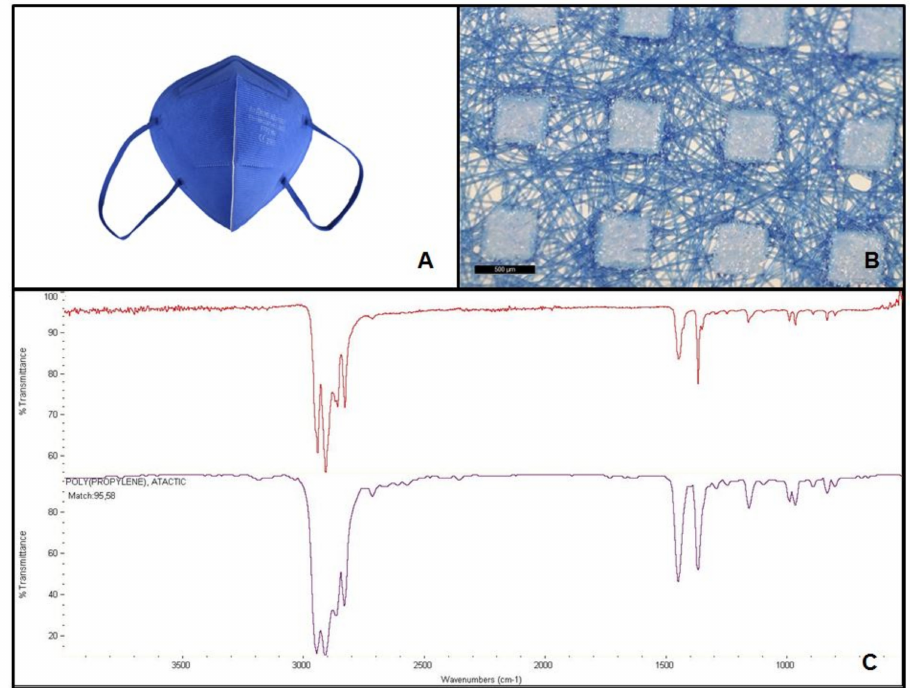
Figure 1. Facial mask FFP2 A studied ( A ); structure after disassembling in layers (500 µ m scale bar) ( B ); and mask spectrum (at the top), spectrum listed in the library (at the bottom) identifying polypropylene, atactic, 95.58% ( C